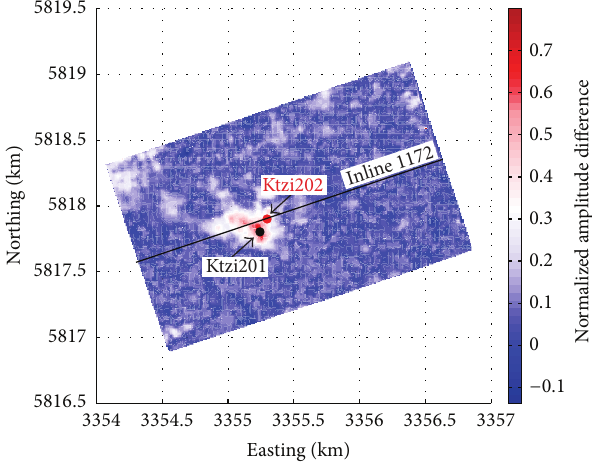
Figure2:Mapofthenormalisedamplitudedifference(repeatminus baseline) at the reservoir horizon (top of Stuttgart Formation). The difference is the result of time-lapse processing of the 3D surface seismic baseline (recorded autumn 2005) and repeat surveys (recorded autumn 2009 [19]). The injection well Ktzi201 and the observationwellKtzi202aremarkedasdots.Theinline1172,whichis crossing the observation well Ktzi202, is indicated by the black